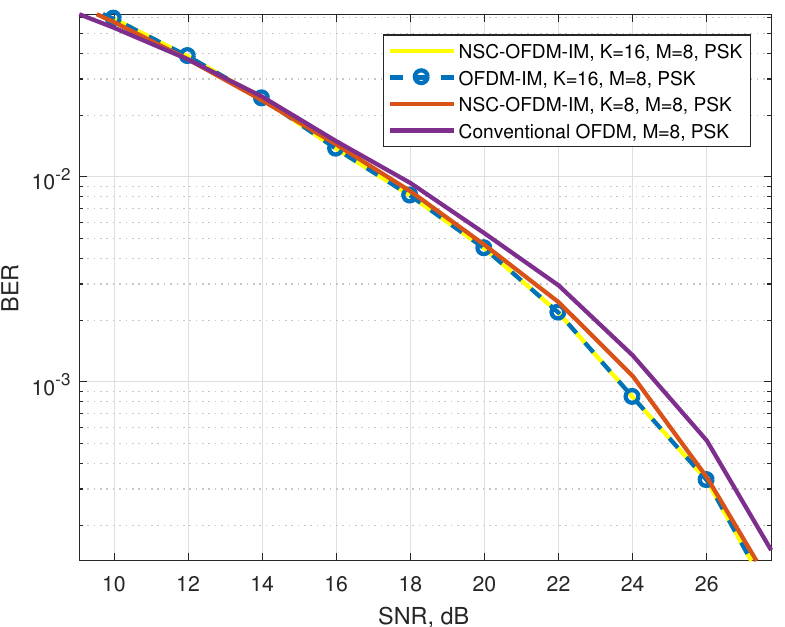
Figure 13. BER performance comparison between the proposed NSC-OFDM-IM and conventional OFDM-IM/OFDM, where 8-PSK modulation was